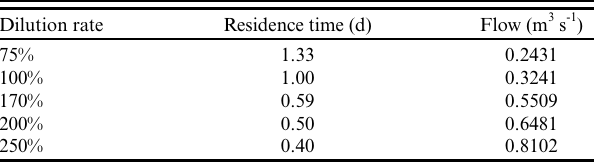
Table 1 . Dilution rates, residence times, and flows adopted in the model.